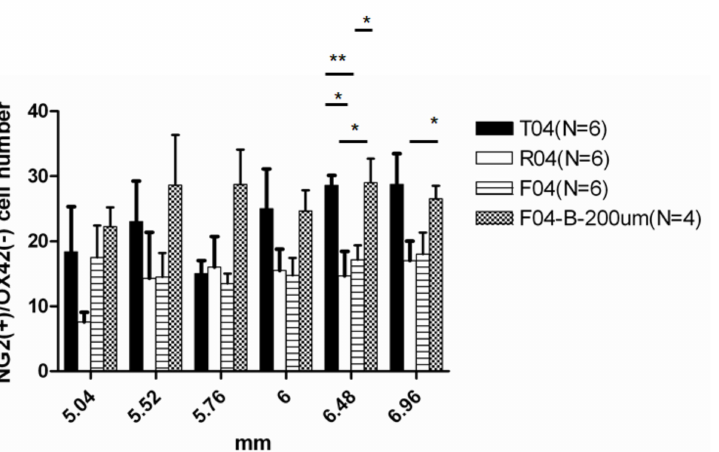
Figure 14. NG2+OX42 − cells in the dorsal funiculus. Statistical analysis for the four groups: T4 = transected, R4 = PNS graft+ FGF-1, F4 = transected+ FGF-1, F4 + B = transected + FGF-1 + PD173074. At distances ranging from 6.68 mm to 6.96 mm from the trauma center, R4 and F4 rats showed lower NG2+OX42 − cells compared to T4 rats, while F4+ blocker restored the number. Statistical significance was evaluated using one-way ANOVA and Tukey’s test *: p < 0.05, **: p < 0.01. Animal number used: T4 ( n = 5) R4 ( n = 6) F4 ( n = 6) F4 + B ( n =